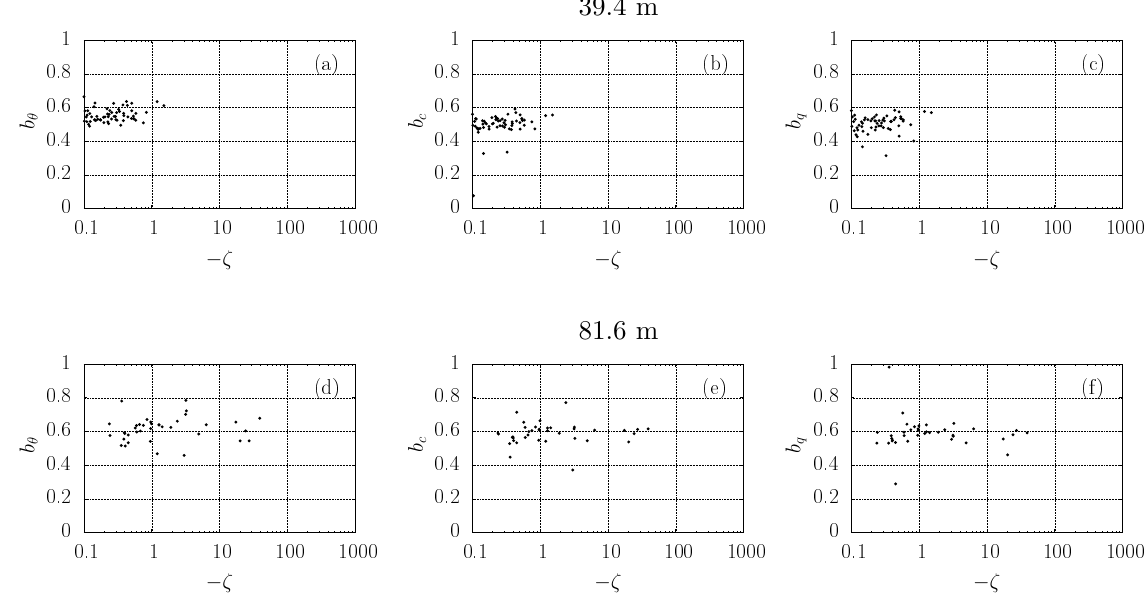
Figure 11. Relaxation coefficient variation with solar angle – 0 ◦ < | Z |≤ 20 ◦ . Panels (a, d) are temperature, (b, e) are CO 2 , and (c, f) are water